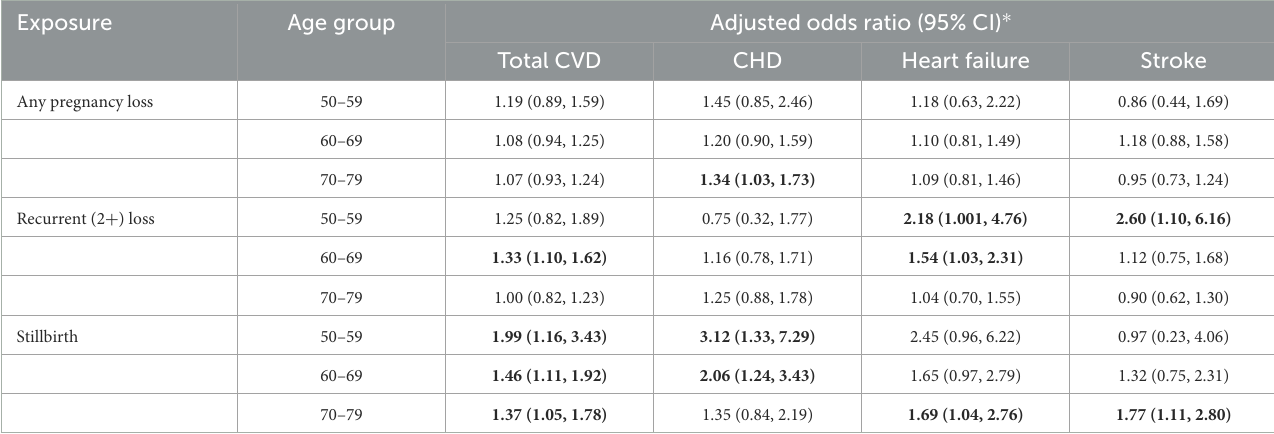
TABLE 3 Odds of incident cardiovascular disease (CVD) within 5 years in women with and without a history of pregnancy loss, recurrent pregnancy loss, and stillbirth, by age at study baseline.